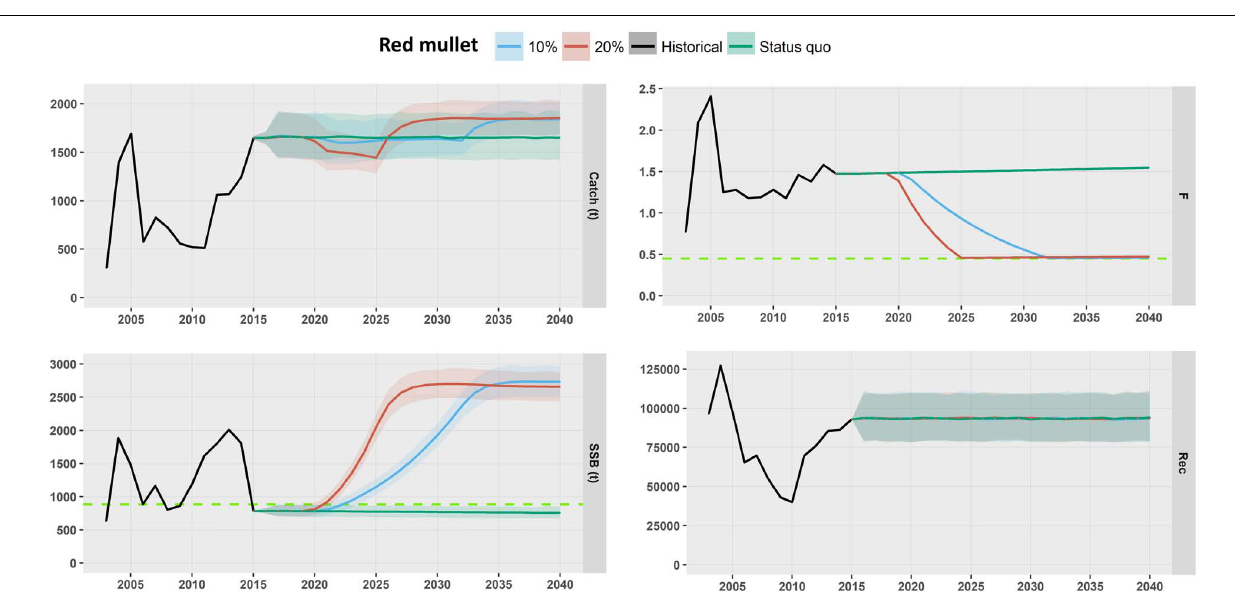
FIGURE 6 | Results of the bioeconomic model of catch (tn), fishing mortality (F 0 − 2 ), SSB (tn), and constant recruitment for M. barbatus under historical series and Scenario 0: status quo ; Scenario 1: 10% annual reduction; and Scenario 2: 20% annual reduction. Dashed lines indicates the FMSY level and SSBlim (computed as SSBlim = 1.4*SSBmin , where SSBmin is the minimum value of SSB observed in the historical data